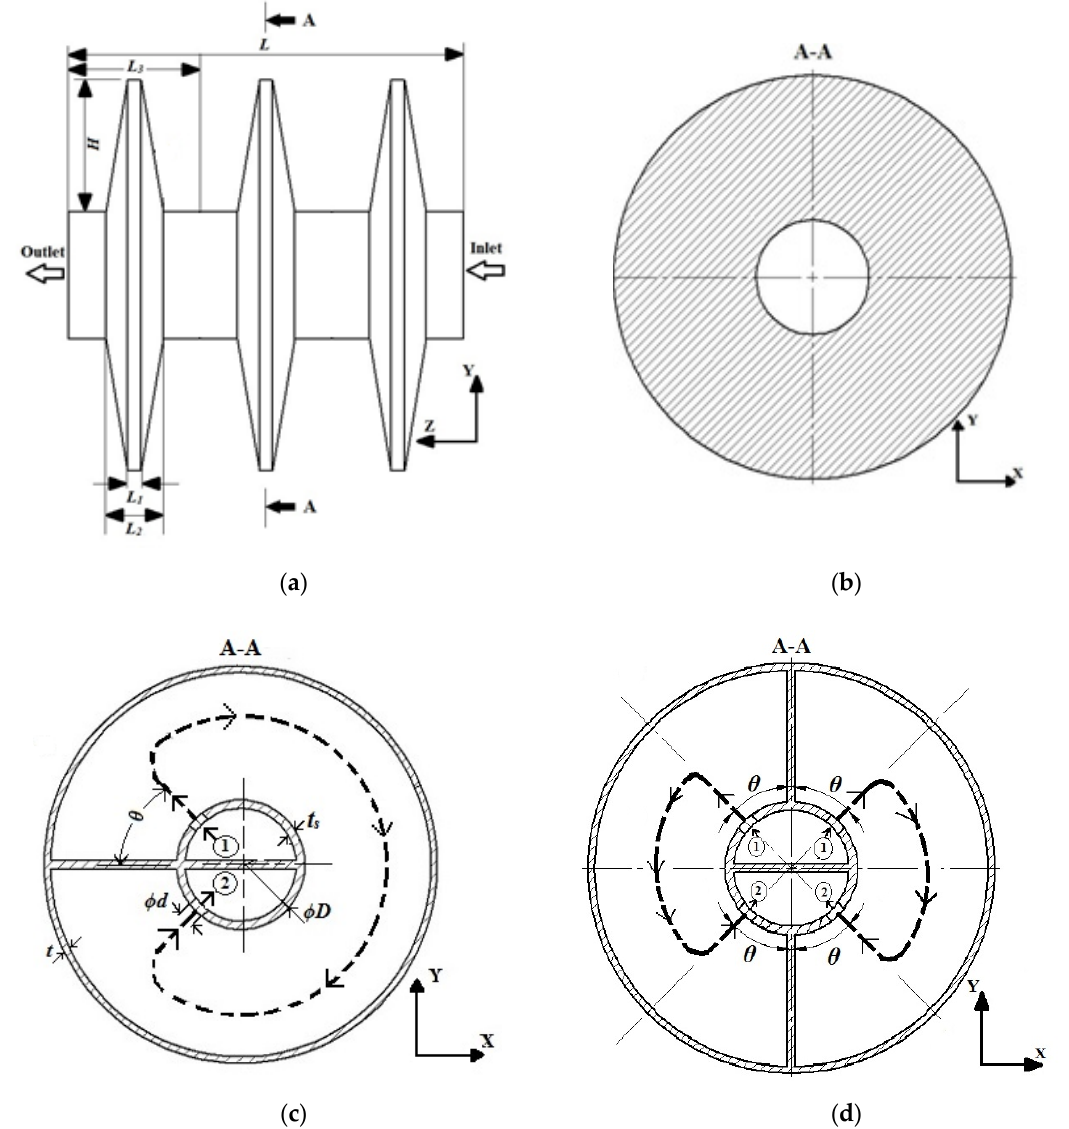
Figure 1. Single-leaf type paddle-shaft components: ( a ) Outer shape, ( b ) solid paddle, ( c ) hollow paddle with two flow holes, and ( d ) hollow paddle with four flow holes.